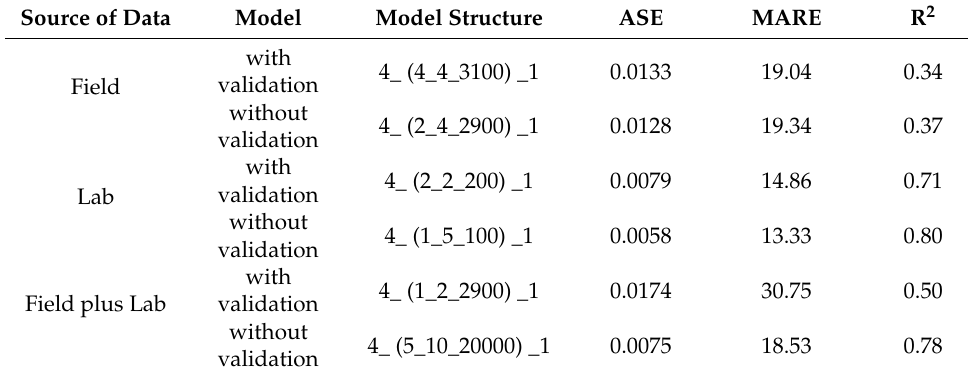
Table 4. Comparing ANN models (predicting seismic wave velocity).